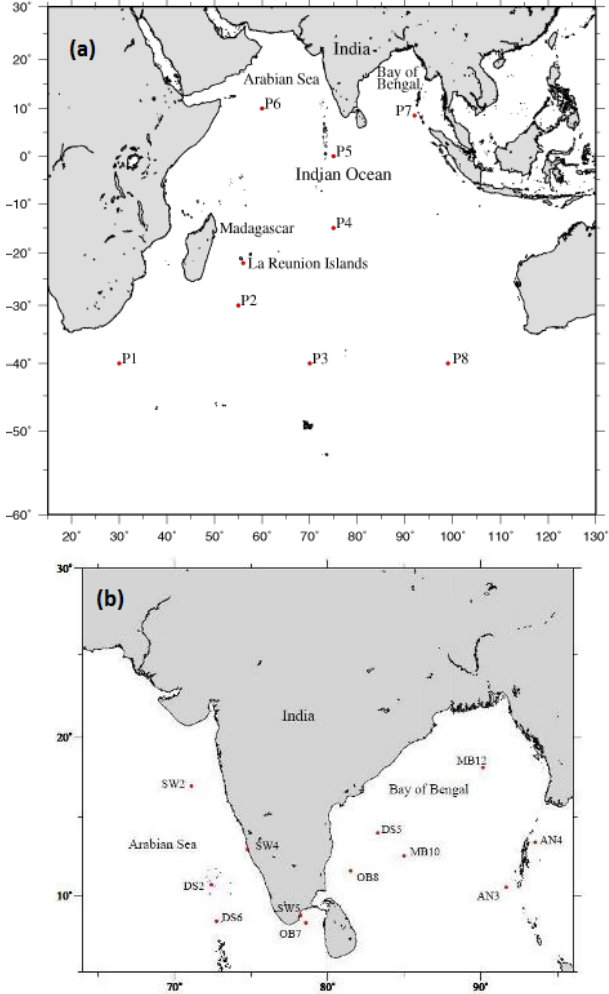
Fig. 1. (a ) Model domain and selected points in the Indian Ocean for studying the propagation of swells during 2007 (b) Buoy mea- surement locations